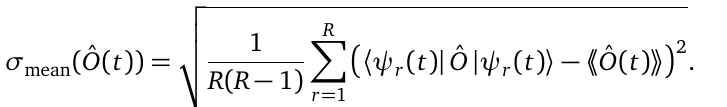
Figure 4: Probability distribution for two or more jump events happening in the same time step to estimate the necessary time step for the model with dissipator D different system sizes and dissipation strengths. The vertical dashed lines mark the time-steps typically chosen in the calculations and the horizontal dotted lines are the corresponding probability for L =